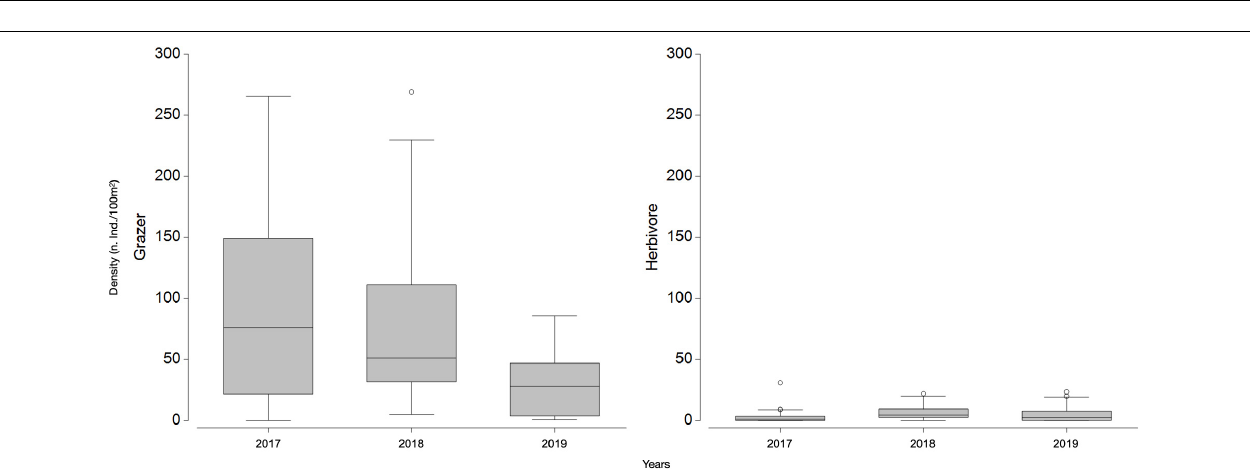
FIGURE 3 | Grazer and herbivore densities (individuals/100 m 2 ) in each of the three considered years (2017, 2018, 2019); boxplot with first quartile, median and third quartile, minimum and maximum as whiskers and points as outliers.